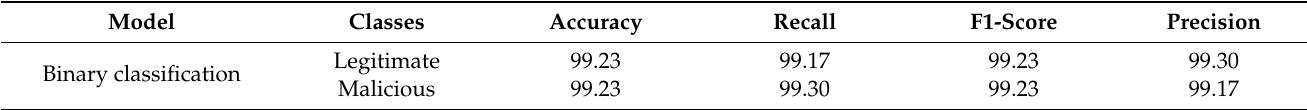
Table 9. Measurement results for 2 classes.